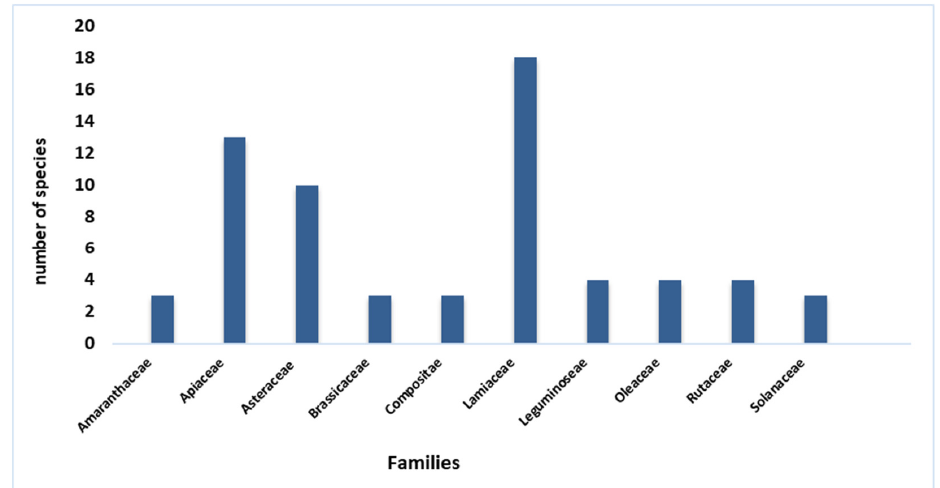
Figure 3. Moroccan medicinal plants families used to treat inflammation Plant